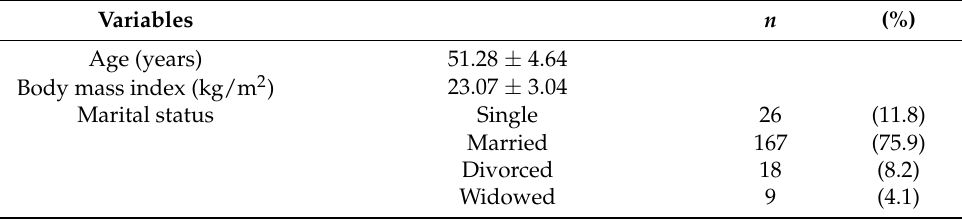
Table 3. Characteristics of the study subjects by categorical variables ( n =